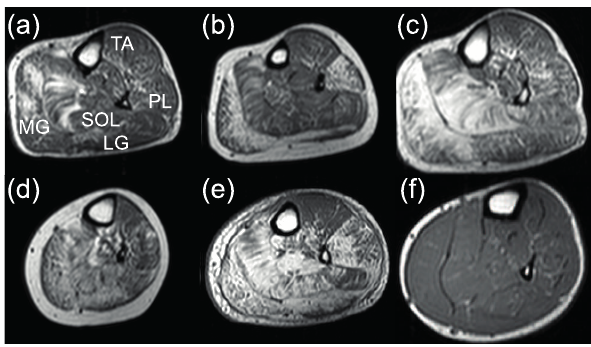
Figure 1. T1 weighted images of the lower leg in LGMD2I patients with increasing severity in pathology (a–e), and in a control subject (f). In image (a) there is involvement of medial gastrocnemius and soleus compared to image (e) where all muscles but tibialis anterior are severely affected. (TA= tibialis anterior, SOL= soleus, PL= peroneus longus, LG= lateral gastrocnemius, MG= medial